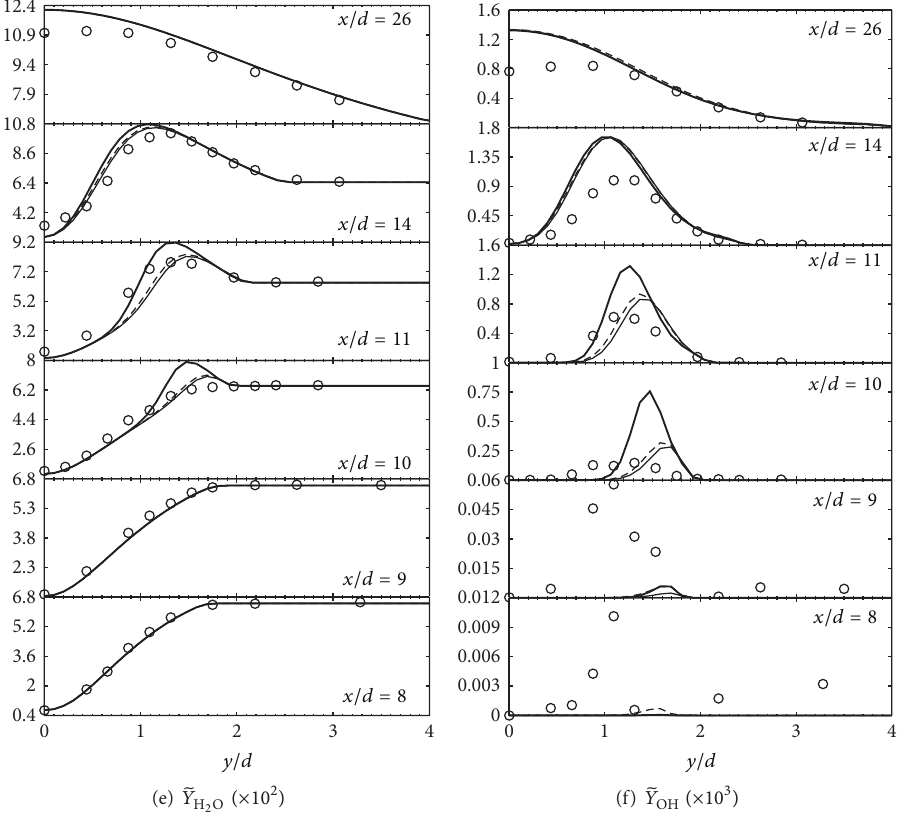
̃𝑌 (× 10 3 ) and radial profiles of (b) ̃𝑇 , (c) ̃𝑌 OH